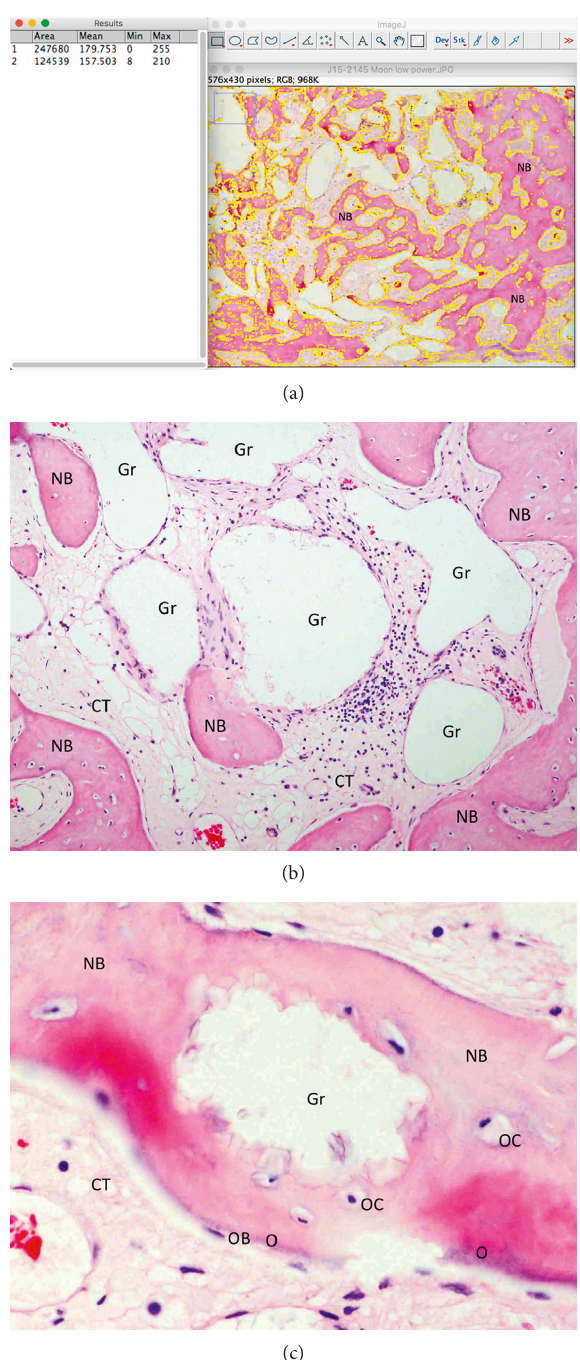
Figure 9: Histological sections of bone core biopsy harvested from the regeneratedsiteusingatrephineburr.(a)Overviewimageofthecoronal- apical cut through the entire core biopsy showing new bone (NB) formation in the extraction socket. The new bone is marked, and its surface was calculated in accordance to the overall surface of the specimen, revealing a 50.28% percentage of new bone (H&E stain, original magnification × 20). (b) EthOss particles (Gr) are embedded in well-perfusedconnectivetissue(CT)andnewlyformedbone(NB)(H&E stain, original magnification × 200). (c) High magnification showing new bone (NB) in contact with a graft particle (Gr). Osteocytes (OC) can be detected inside the new bone and osteoblasts (OB) forming osteoid (O) on its outer surface (H&E stain, original magnification × 400).